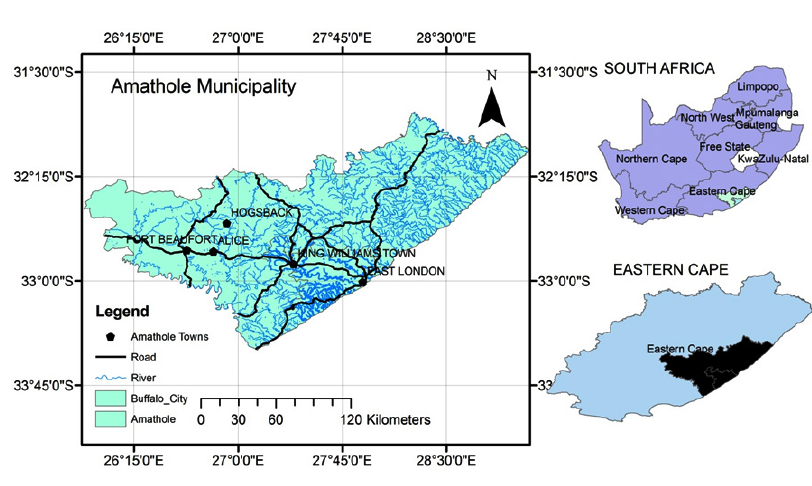
Fig. 1. Map of Amathole District Municipality (26)